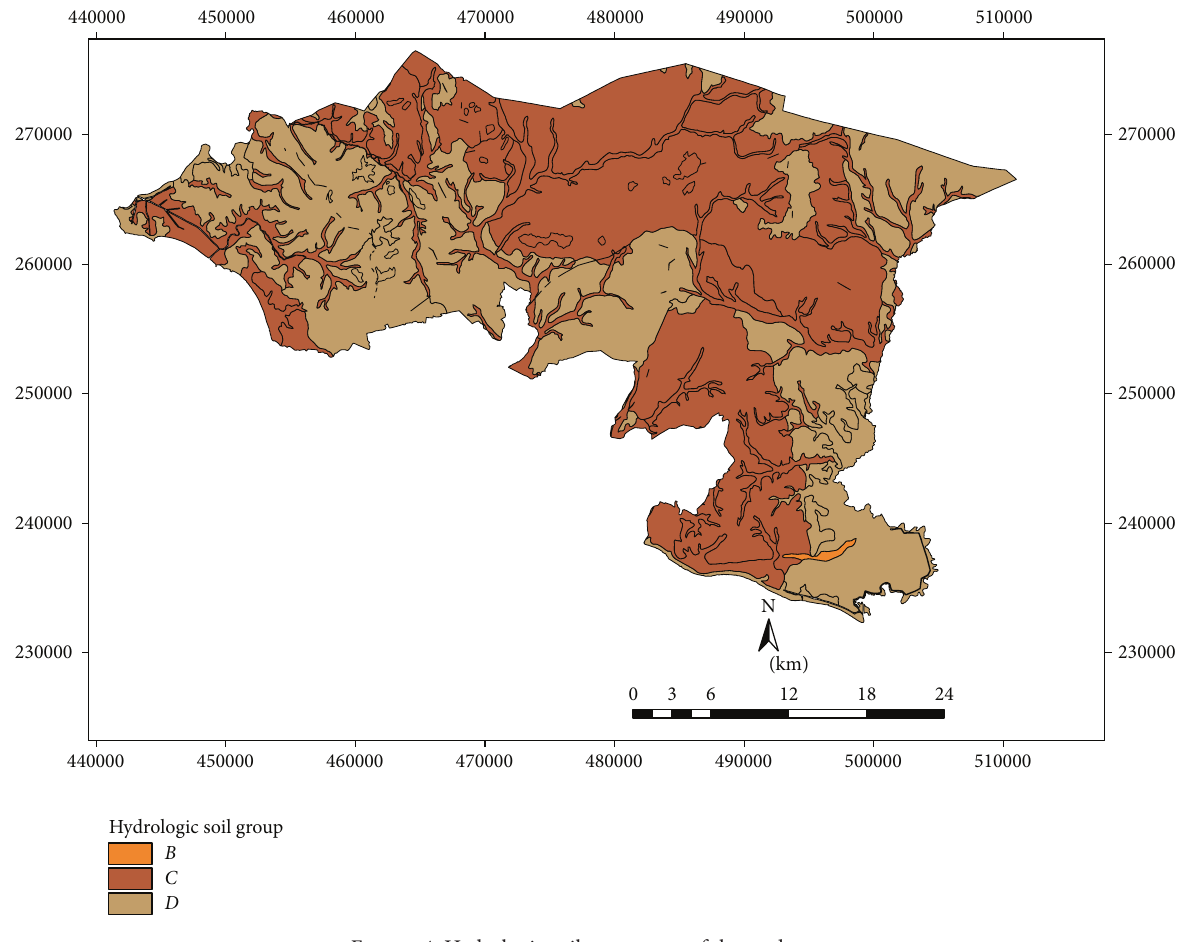
Figure 4: Hydrologic soil group map of the study